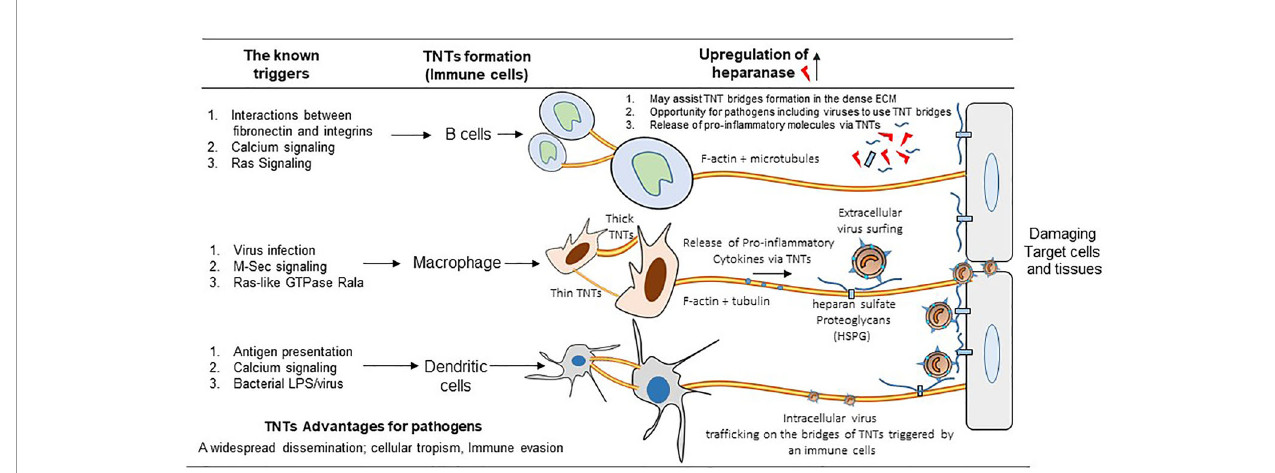
FIGURE 3 | Signi fi cance of TNTs among the circulating immune cells. The cartoon highlights the common triggers including the virus infection generating various types of TNTs among B cells, macrophages, and dendritic cells. In parallel, the upregulation of heparanase together with the presence of heparan sulfate and the release of pro-in fl ammatory cytokines further aids in the TNT dependent viral infectivity (either the extracellular and or the intracellular virus traf fi cking using the circulating immune cells) resulting widespread dissemination of the virus to affect distantly located multiple